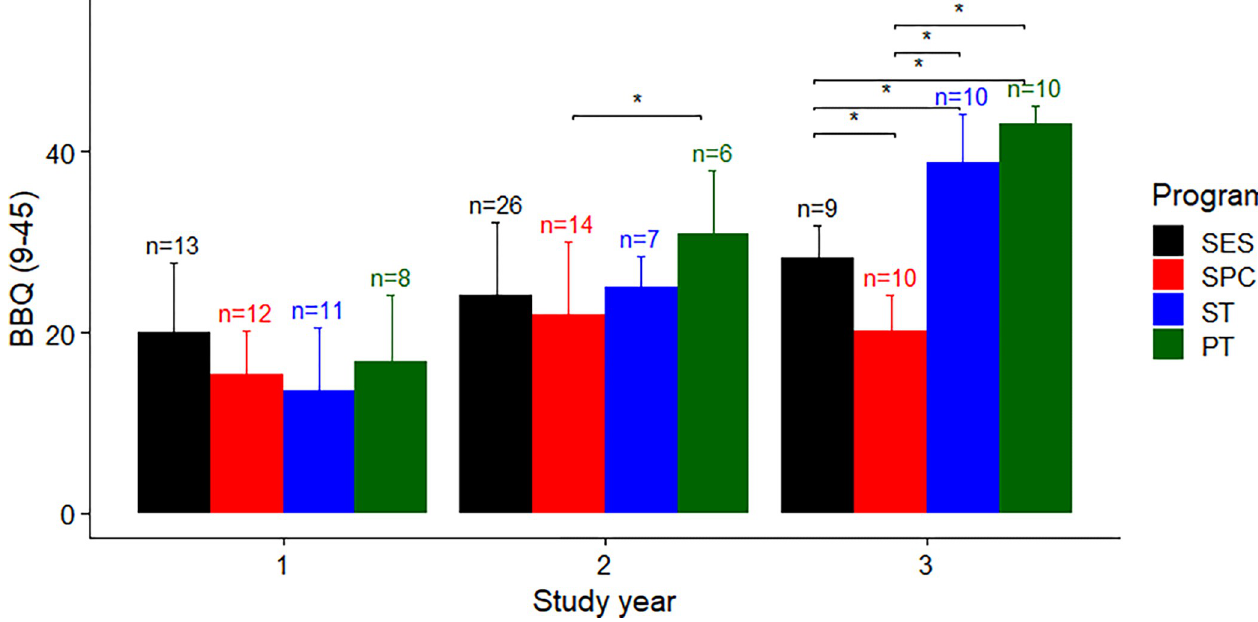
Fig 2. Group average with error bars as one standard deviation of the total score of the Tampa Scale of Kinesiophobia 11-item version, for each study programme and year. * Indicates a statistically significant (P < 0.05) pairwise difference. Abbreviation: SES–Sport and Exercise Science, SPC–Sport and Performance Coaching, ST–Sports Therapy,